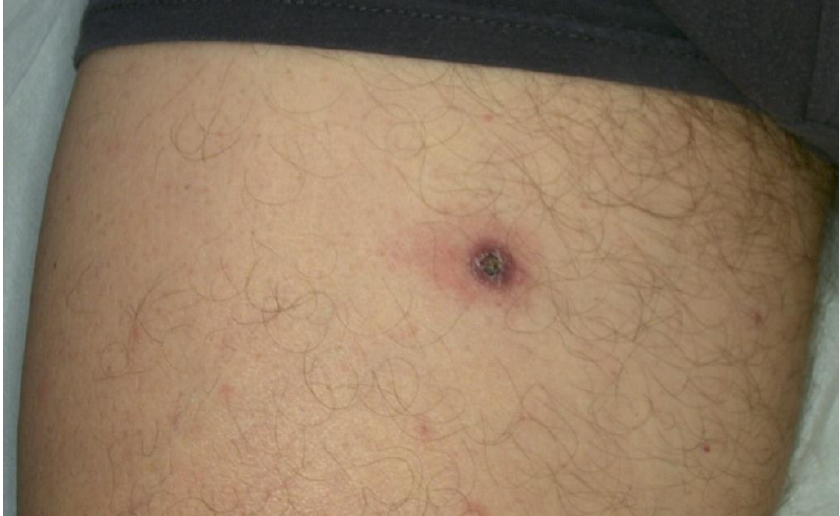
Figure 1. Clinical image of the lesion on the upper thigh of the patient. The patient described the lesion as enlarging and non-pruritic, and negated associated fever, lethargy, headache, arthralgia, lymphadenopathy, or other novum skin lesion during the first visit. No regional lymphadenopathy, tenderness to palpation, or mucosal involvement was recorded during the physical examination. To exclude non-melanoma skin cancers, a dermoscopic examination and a skin biopsy were performed. The dermos- copy showed an erythematous, copper-colored, oval lesion with diffuse monomorphic dotted and glomerular vessels, central crust and circular scaling (Biett ’ s sign) (see Figure 2). Figure 2. Dermoscopic image showing an erythematous, copper-colored, oval lesion with diffuse monomorphic dotted and glomerular vessels, central crust and circular scaling (Biett ’ s sign). The histopathologic evaluation showed a dermal inflammatory infiltration of lym- phocytes, histiocytes, and plasma cells with a superficial and deep perivascular distribu- tion, and the endothelial swelling of dermal blood vessels (Figure 3).